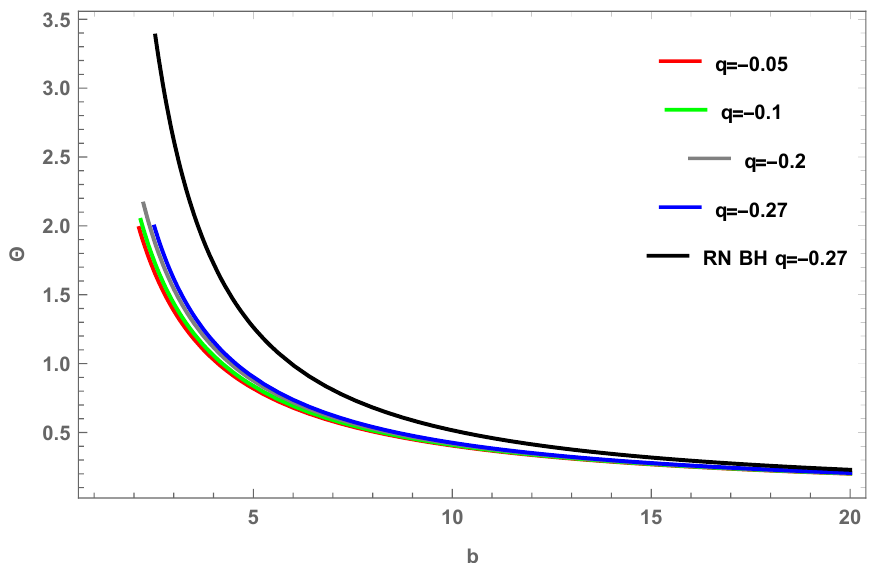
Figure 2. Relation between Θ and b of TCBH for negative values of q for M p = 1, M 5 = 0.5, M =